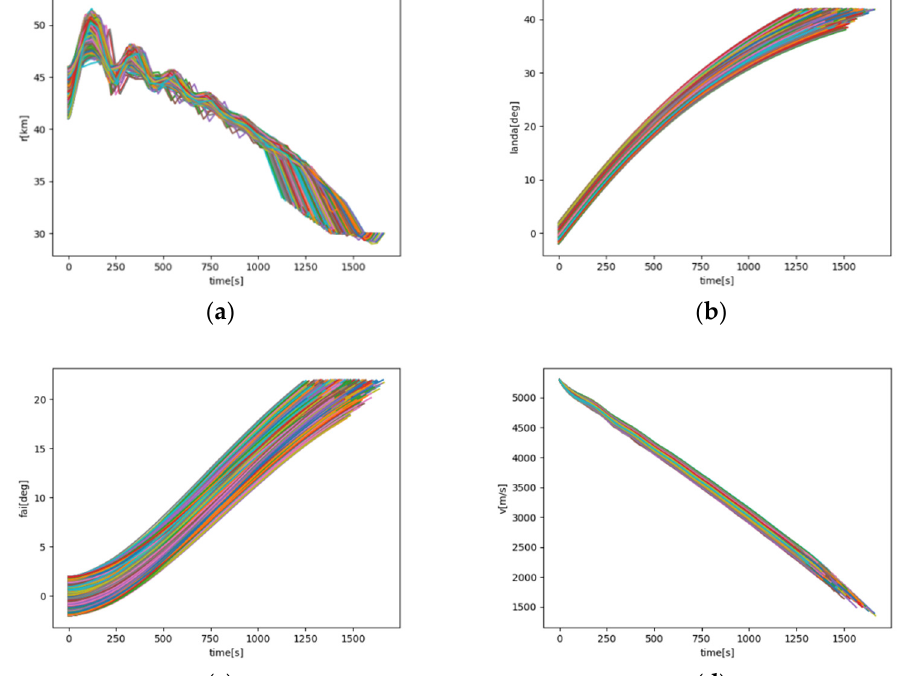
Figure 3. State of training data. ( a ) Height–time curve; ( b ) Longitude–time curve; ( c ) Latitude–time curve; ( d ) velocity–time curve.